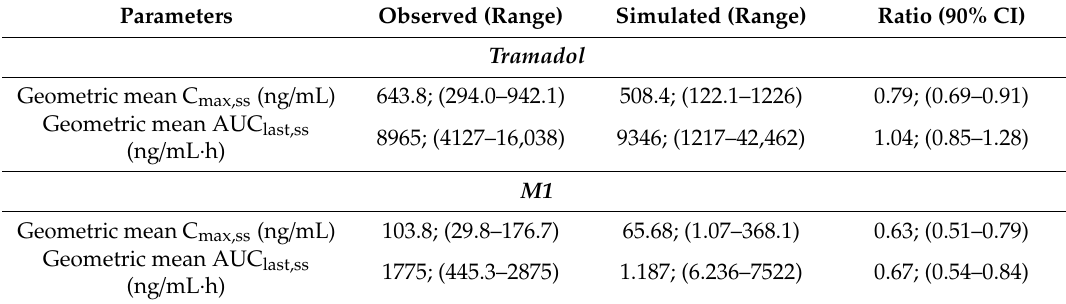
AUC last : area under the curve from 48 h to 120 h at steady-state; CI: confidence interval; C max,ss : maximum drug concentration in plasma at